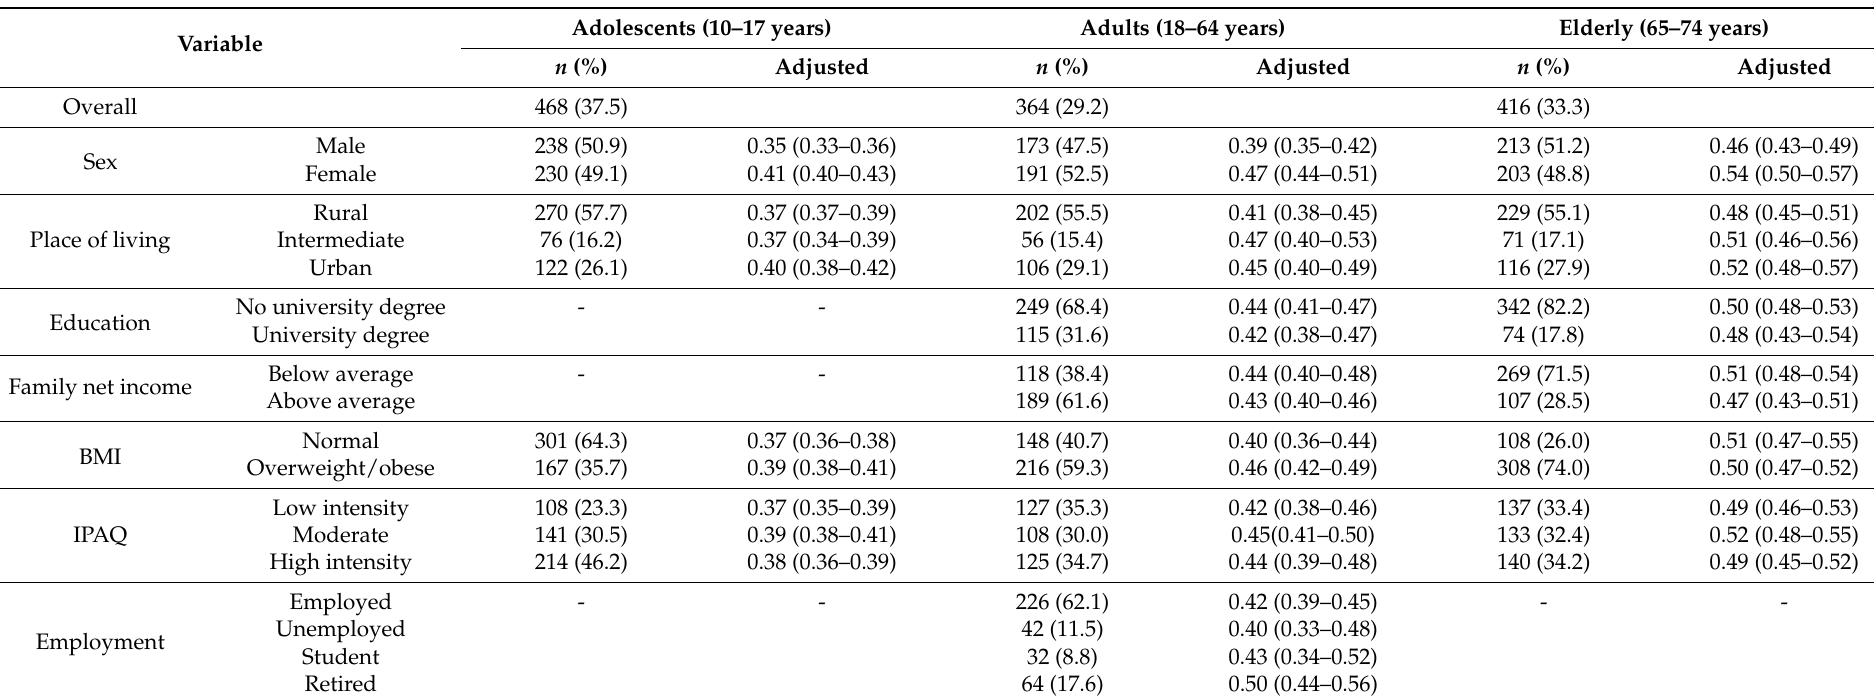
Table 2. Adjusted mean (95% CI) levels of trans fatty acid (TFA; % TEI) intake by gender, region, body mass index (BMI), international physical activity questionnaire (IPAQ) score, education, income, and employment for different age